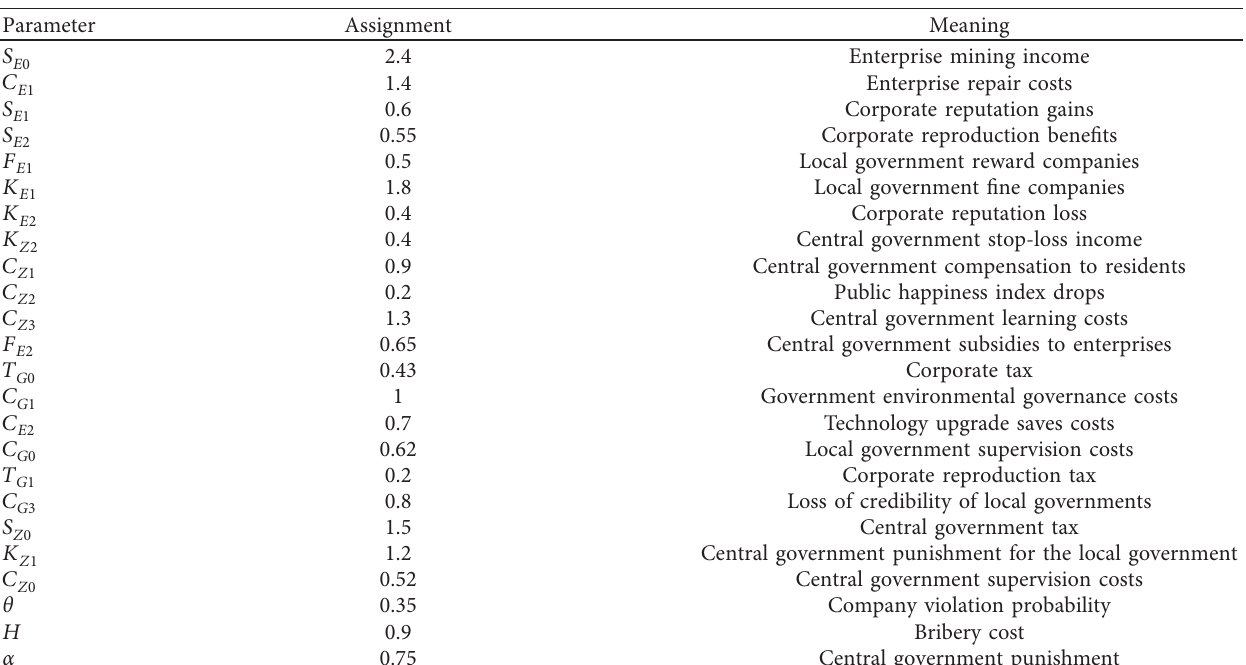
Figure 1: Tripartite evolution of system dynamics. Table 4: Assignment